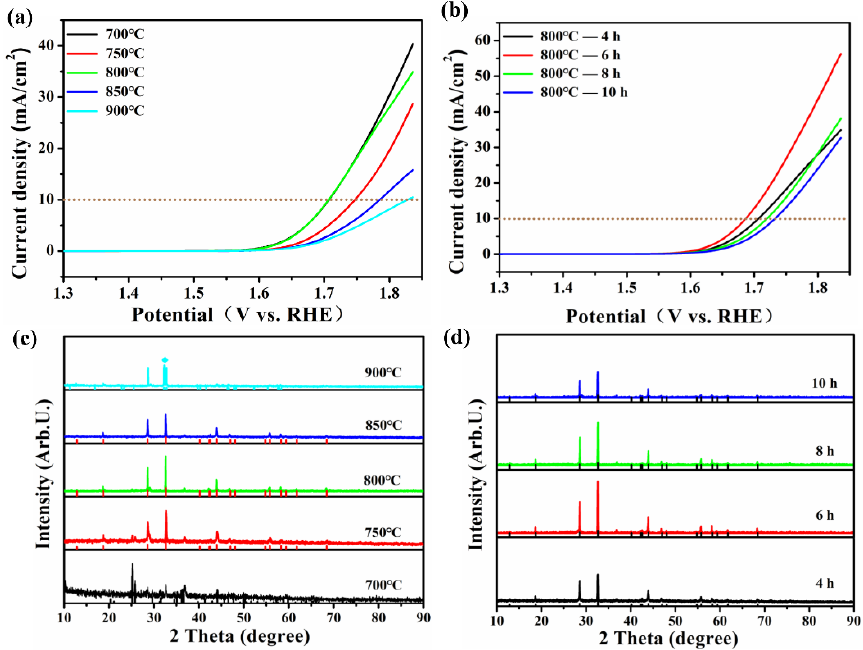
Figure 2. OER polarization curves of SrCoO 3 − x calcined at ( a ) different temperatures (700–900 °C) for 6 h and ( b ) 800 °C for different times (4–10 h) and corresponding XRD patterns ( c , d ).